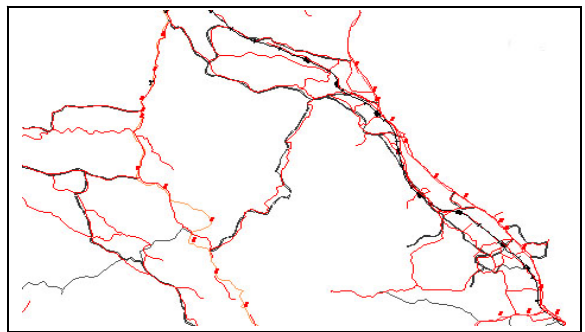
Figure 2. The overlay of three different traffic data Figure 2 is the overlay of three different traffic data which are symbolized by red, yellow and black respectively.